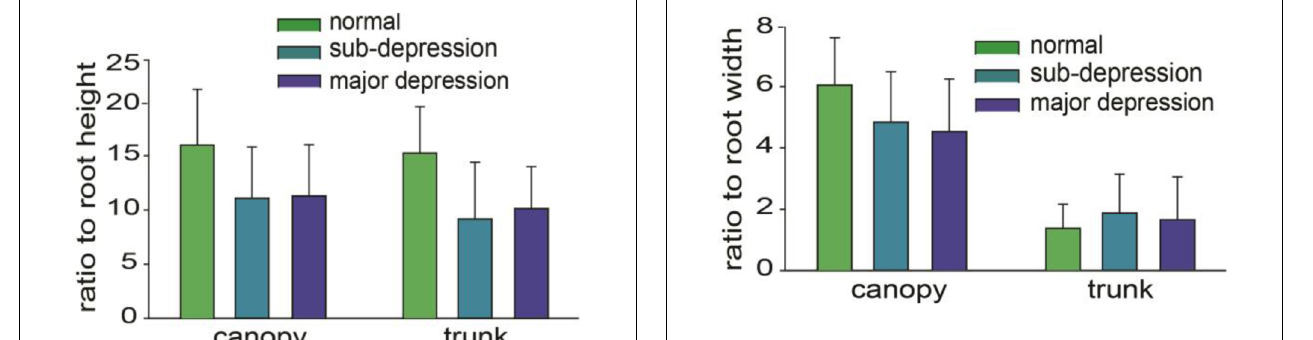
FIGURE 6 | Ratio of canopy width and trunk width to root width, the differences were not statistically significant ( p > 0.05, one way ANOVA). TABLE 4 | Variable assignment description ( n =